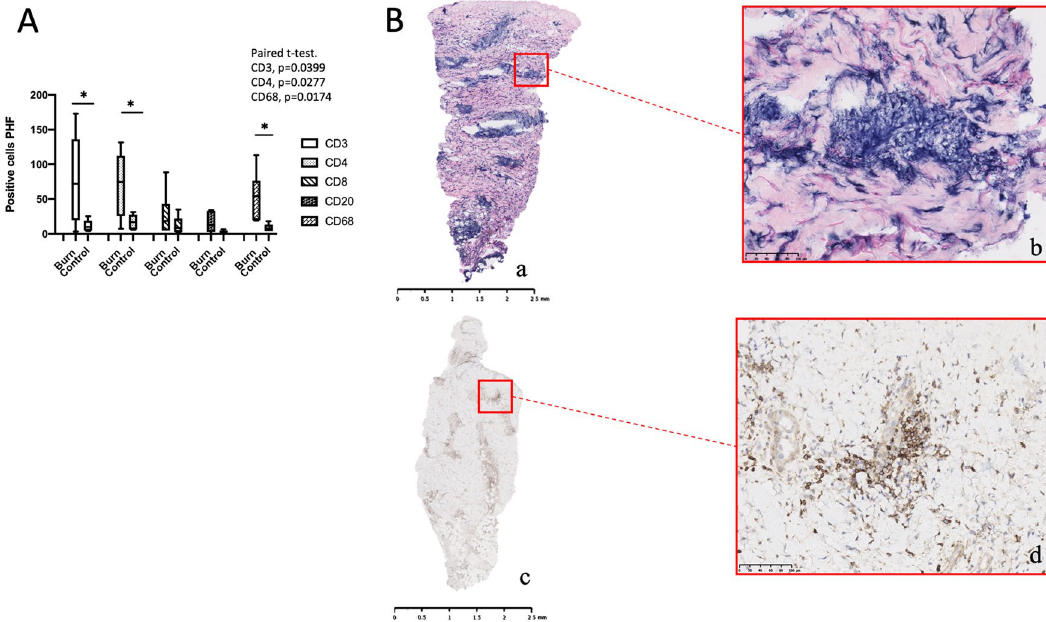
10 μm fresh frozen section and CD4 + stain (b) and 4 μm formalin fixed paraffin embedded section from adjacent area in same wound. Presented with scale bars. Note bands showing increased formazan deposits in reticular dermis of skin in regions anatomically correlating to regions increased CD4 + positive staining. Red boxes showing highlighted regions to demonstrate correlation between LDH staining and CD4 + staining. Scale bars shown in